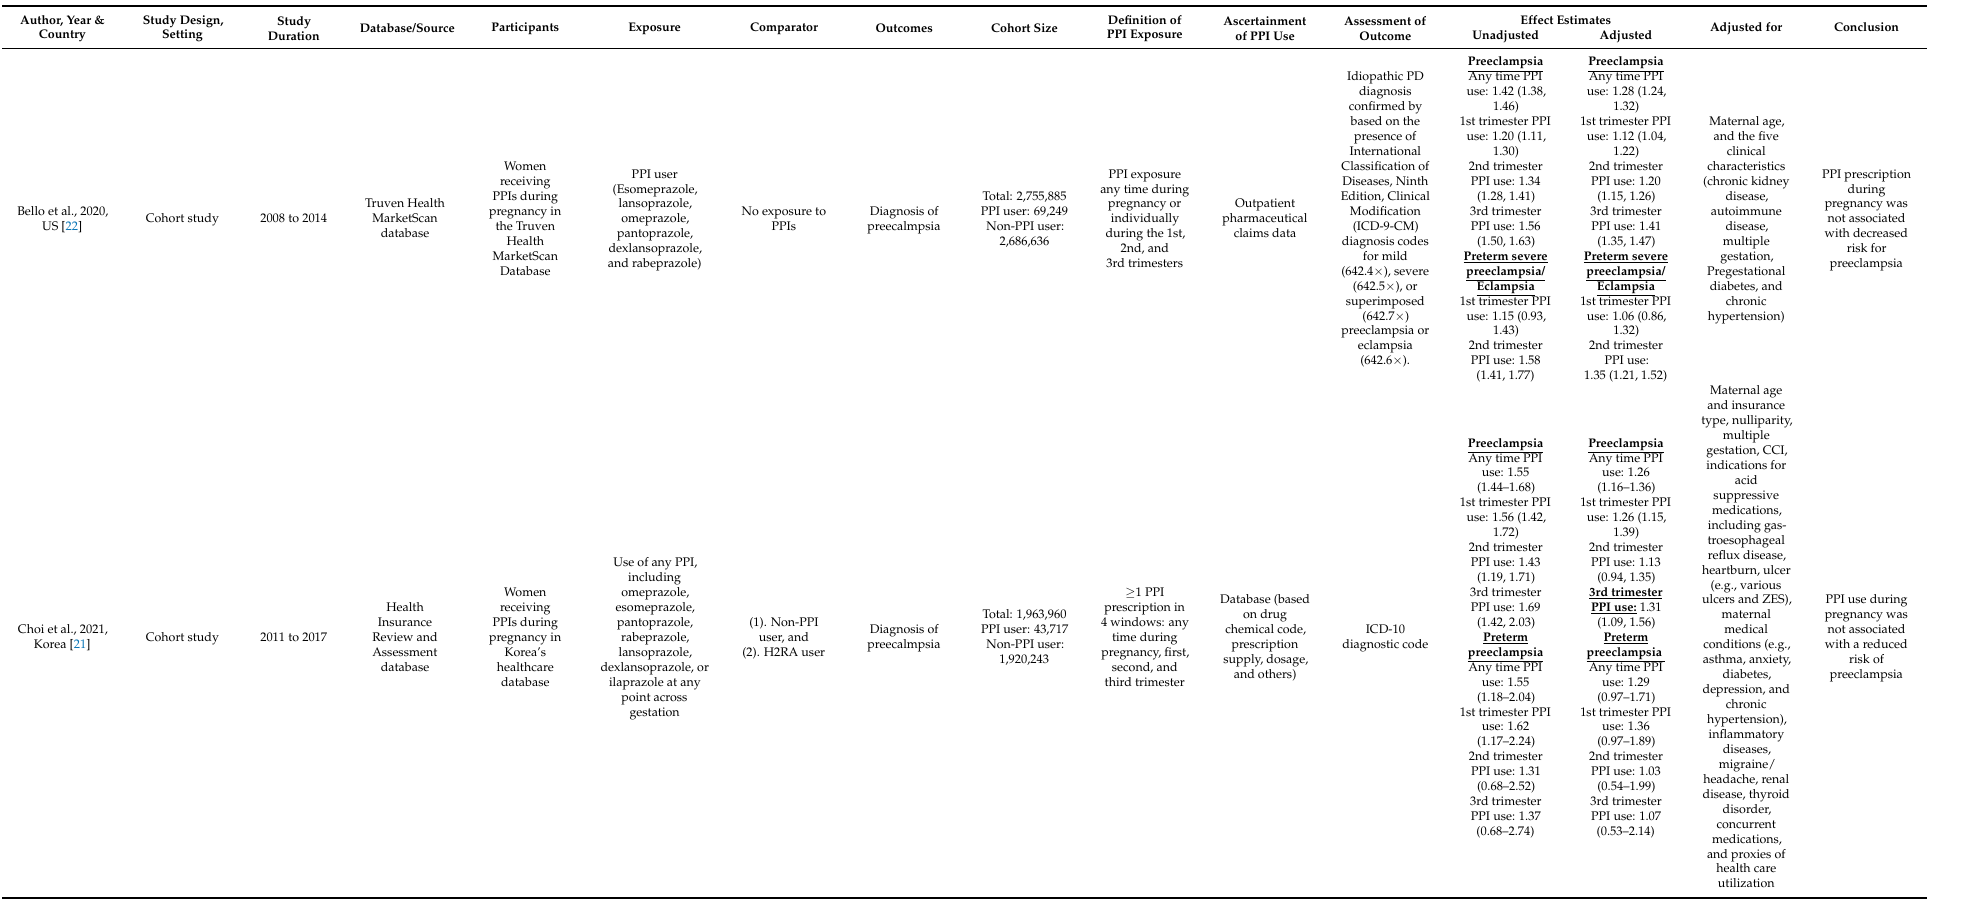
Table 2. Characteristics of the included